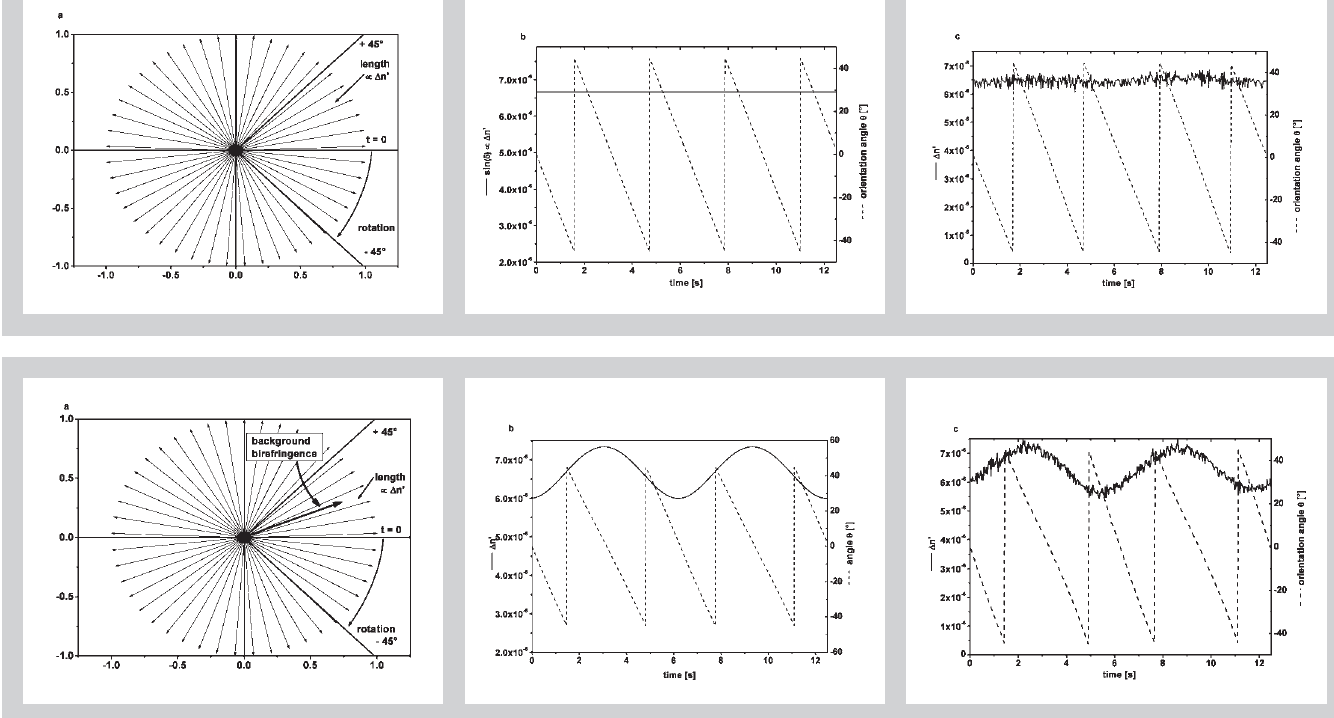
Figure 3 (above): Vectorial representation of the birefringence signal Fig- ure 3a of a rotating quarter- wave plate without any residual birefringence. Resulting length of the vec- tor Figure 3b representing the birefringence D n’ and corresponding angle q of a rotating quarter-wave plate without residual birefrin- gence according to Figure 3a. Measured birefringence and corresponding angle of a rotating quarter-wave plate without residual bire- fringence Figure 3c accord- ing to Figure 3a. Figure 4: Vectorial representation of the resulting birefringence vector Figure 4a of a rotat- ing quarter-wave plate with offset residual birefringence vector. Here no birefrin- gence compensation was done. Resulting length Fig- ure 4b of the vector repre- senting the birefringence D n’ and corresponding angle q of a rotating quar- ter-wave plate with residual birefringence according to Figure 4a. Measured bire- fringence and correspond- ing angle of a rotating quarter-wave plate with residual birefringence Figure 4c according to Figure